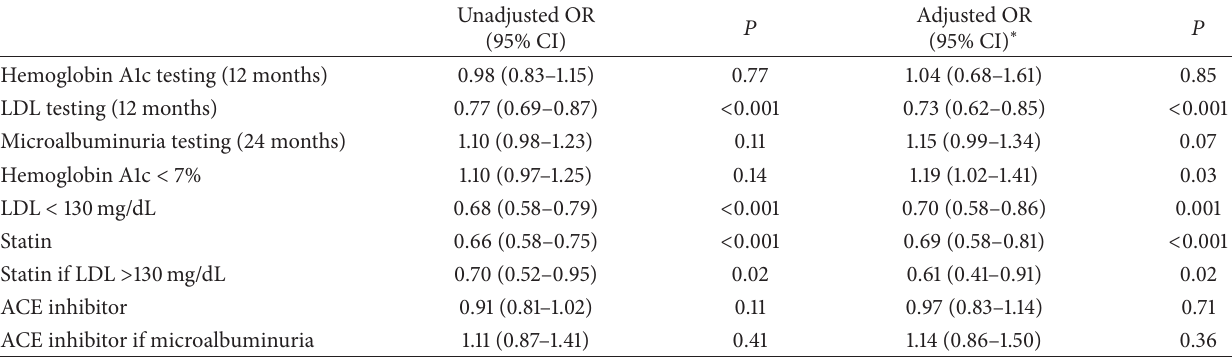
Table 3: Logistic regression models of diabetes process measures for women compared to men in the pathways study. Unadjusted OR